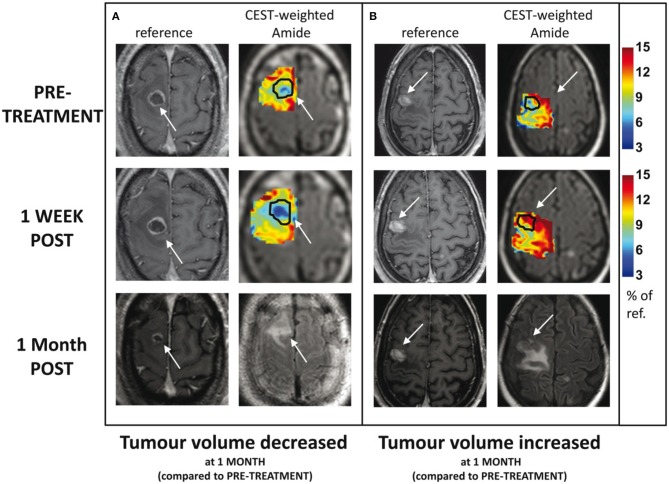
Example CEST amide effect maps within the tumor and immediately surrounding tissue, including edema, at baseline and 1 week post-treatment for 2 patients: (A) tumor volume decreased 1 month post-therapy and (B) tumor volume increased 1 month post-therapy. The margins of the enhancing tumor are indicated with an arrow and outlined in black on the CEST maps. The corresponding slice from the high resolution, contrast-enhanced T1-weighted volume is shown for comparison. Contrast-enhanced T1-weighted and FLAIR images at 1 month follow-up are shown in the third row. Reproduced, with permission, from Desmond et al. (48).